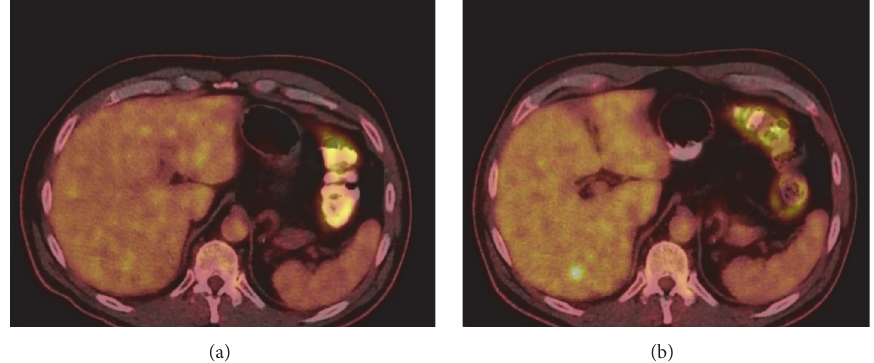
Figure 1: PET/CT at 4 months (a) and 8 months (b) after total thyroidectomy. There is new focal uptake within the posterior right lobe of the liver, measuring a maximum SUV of 5.4, consistent with metastatic disease. This was not evident on the initial PET/CT.